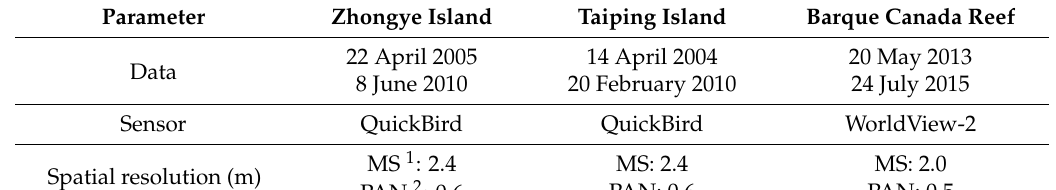
Table 1. Satellite images’ information specific to the study